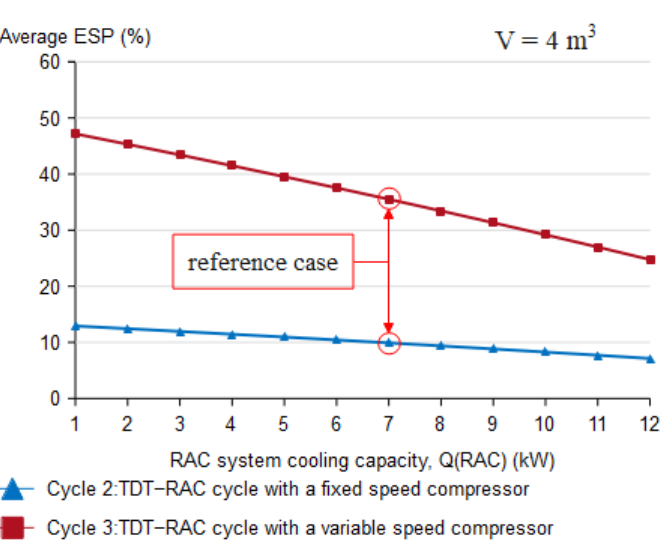
Figure 10. Average ESP versus RAC system cooling capacity (the tank size is set as 4 m 3 ).